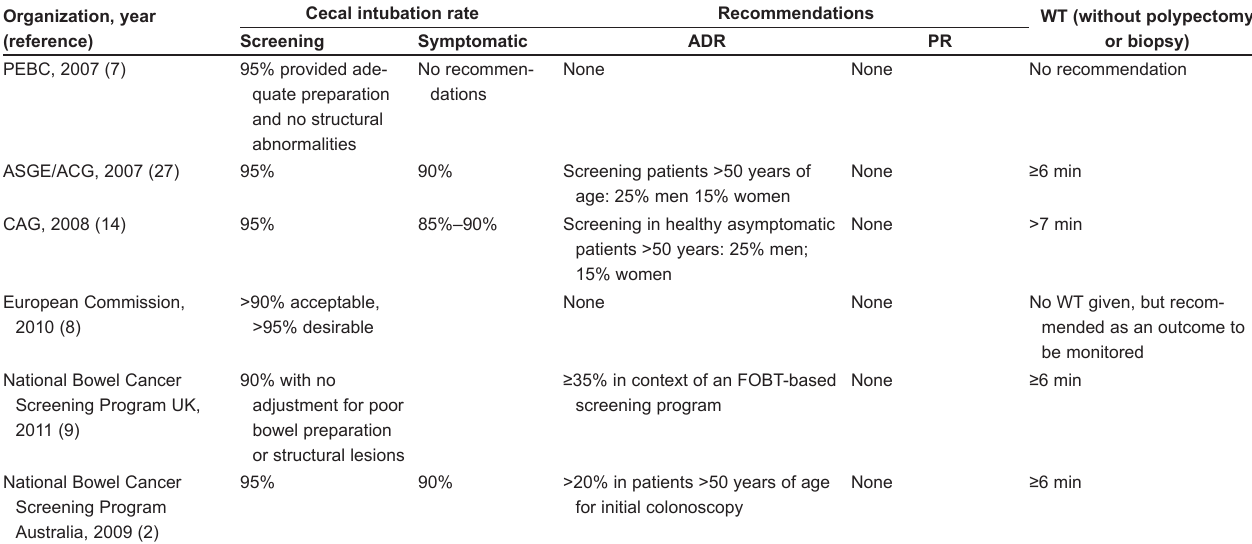
TAble 4 Quality recommendations found in the review of existing